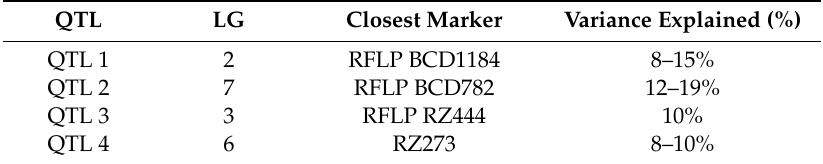
Table 4. QTLs detected by Sim et al. [127] for ryegrass crown rust in an Italian × perennial ryegrass